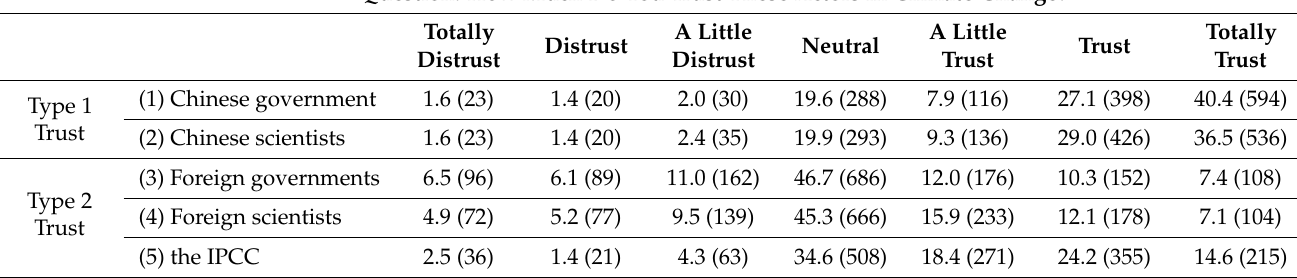
Table 4. Participants’ institutional trust ( n = 1469).